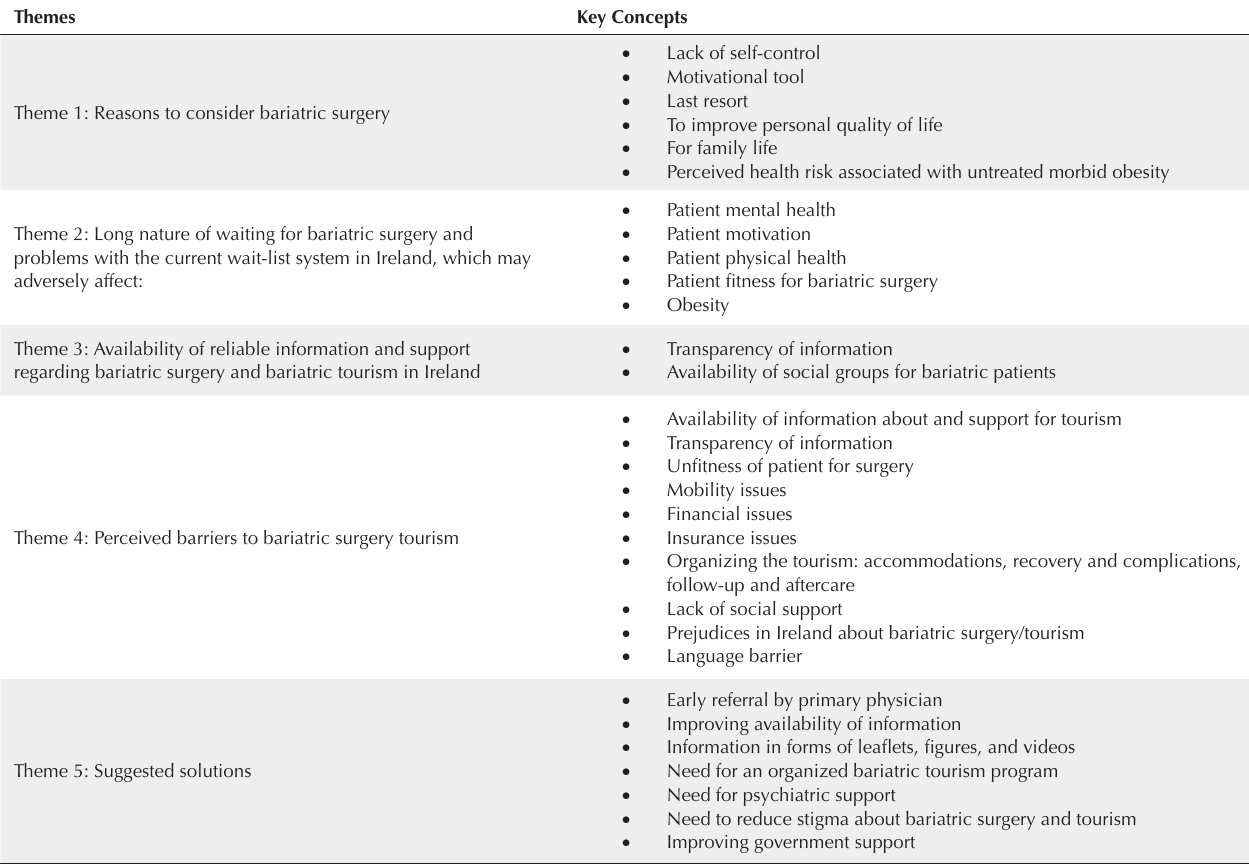
Table 1. Overview of Themes and Key Concepts